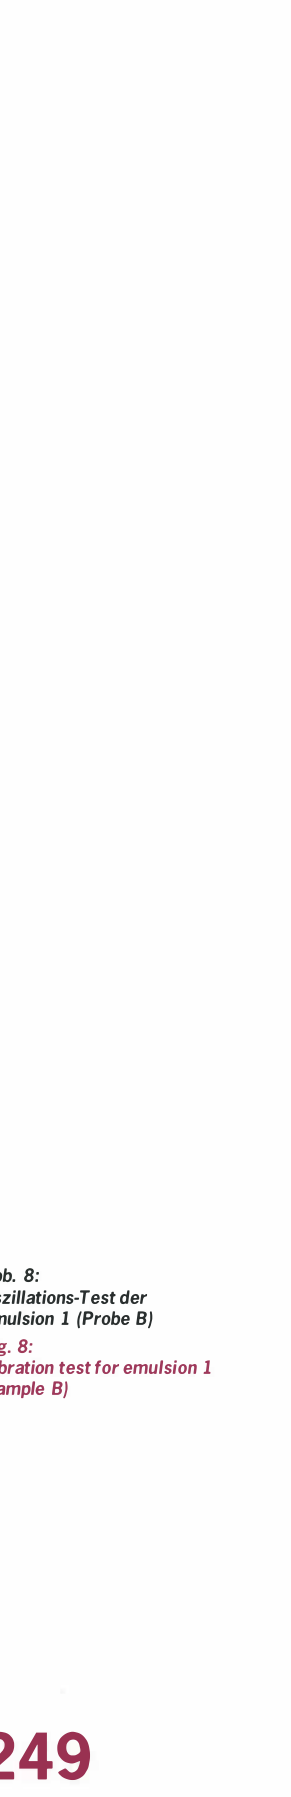
Fig. 6: Vibration test for binder solution 1 (sample A}